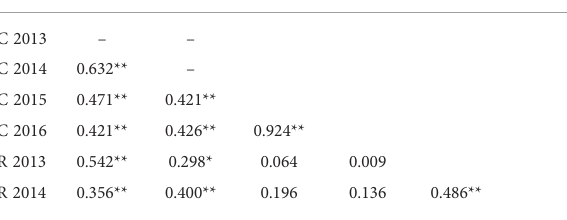
TABLE 3 Genetic intra-trait correlations between mean scores (male cone production) of clones in paired